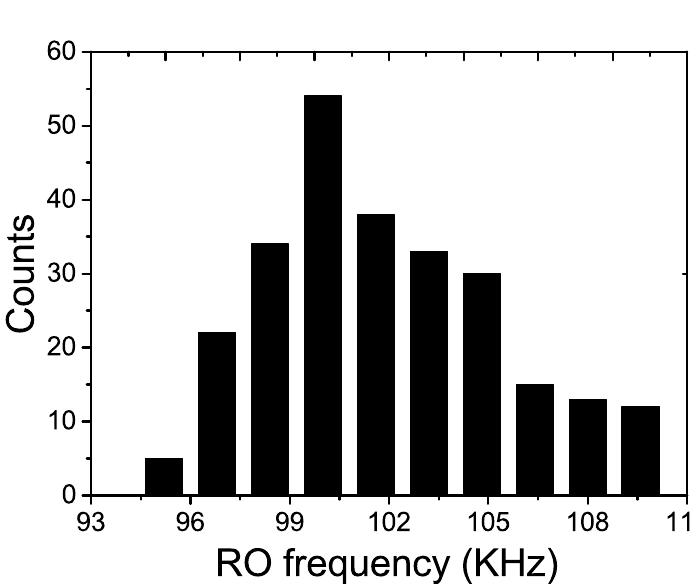
Figure 5. The probe station for testing the sample chips.